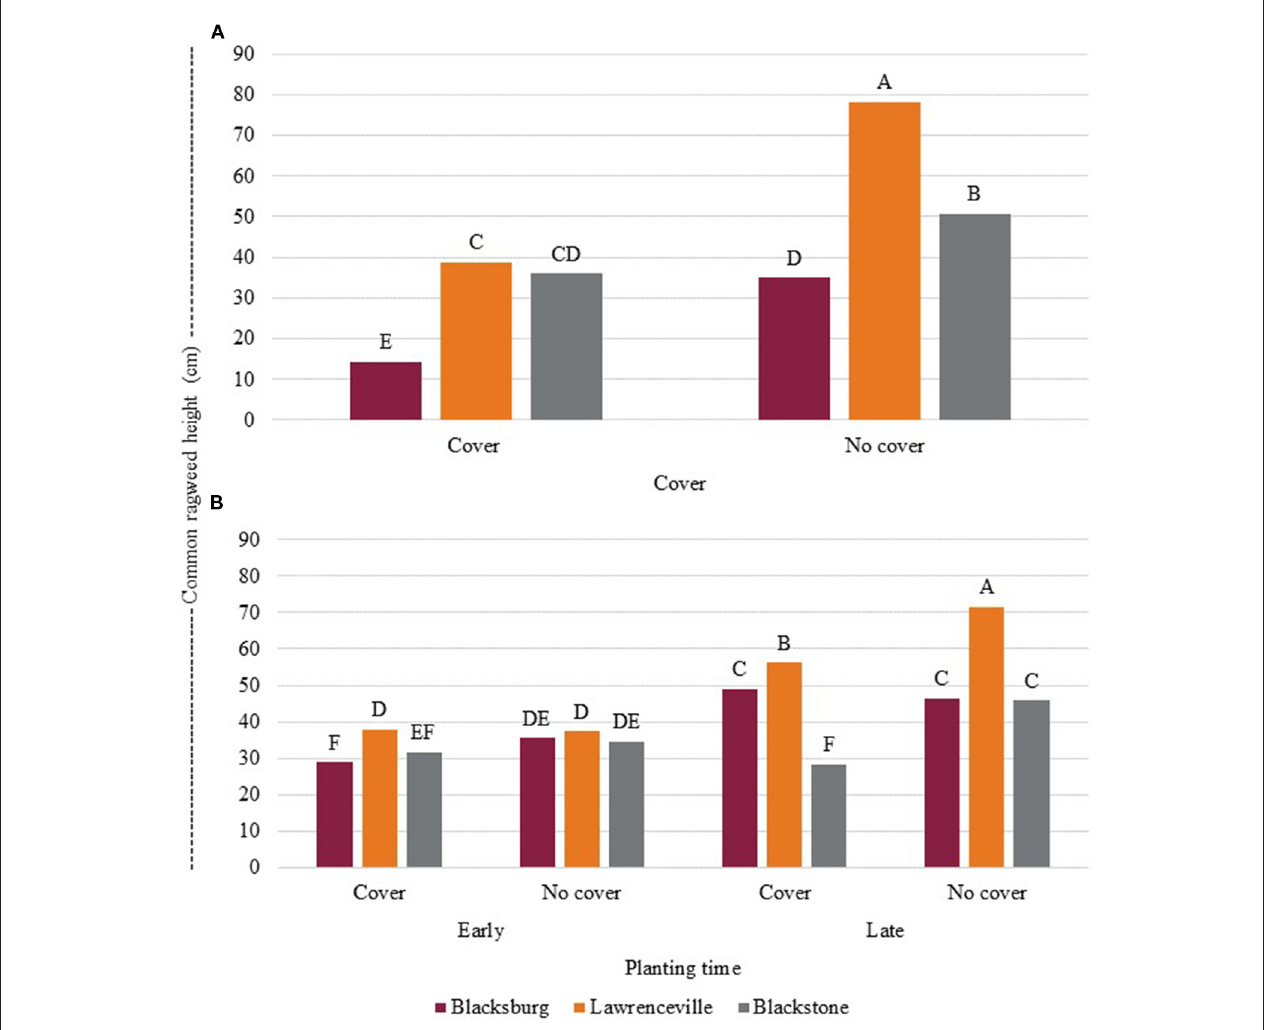
FIGURE 2 | Common ragweed height (A) at late planting across all locations in year 1 of the field experiment and (B) at POST herbicide application (6 wk after planting) by location, planting time, and ± winter cover (cereal rye for early planting and winter wheat for late planting) in year 1 of the field experiment. Means are considered statistically different when they do not share a letter according to Fisher’s Protected LSD ( P = 0.05) .